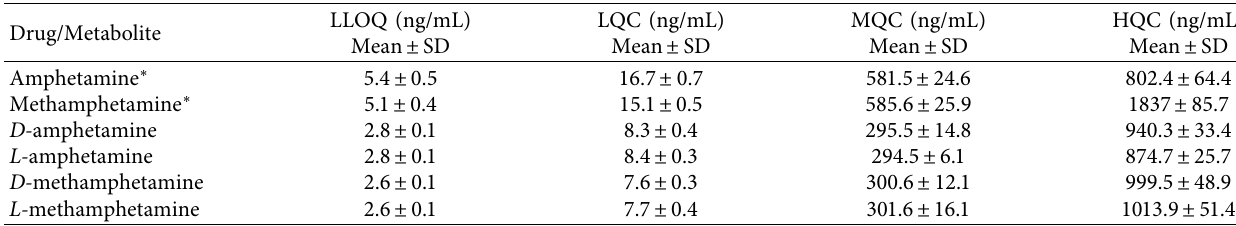
Table 4: Interassay mean and standard deviation (SD) of validation samples.